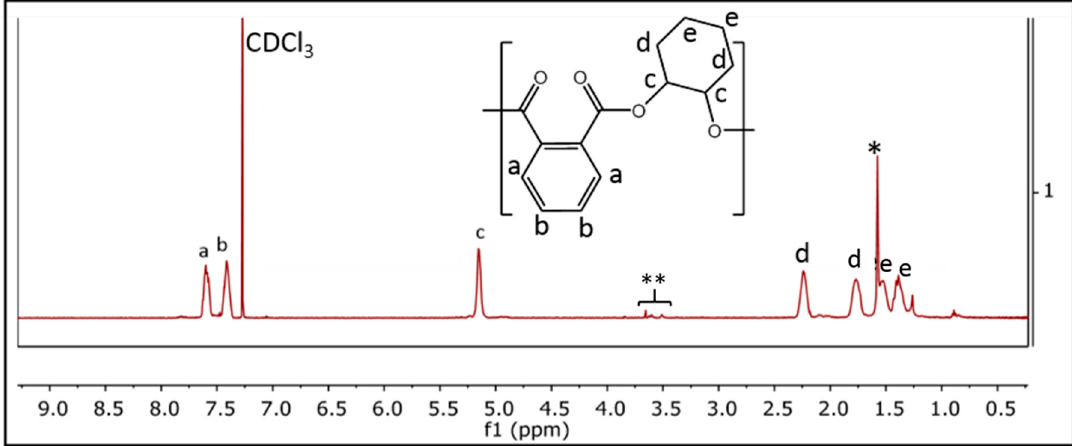
Figure 1. Representative 1 H NMR spectrum of the PE (entry#3 in Table 2). * represents water impurity in the CDCl 3 solvent, ** represents ether linkage in the PE.